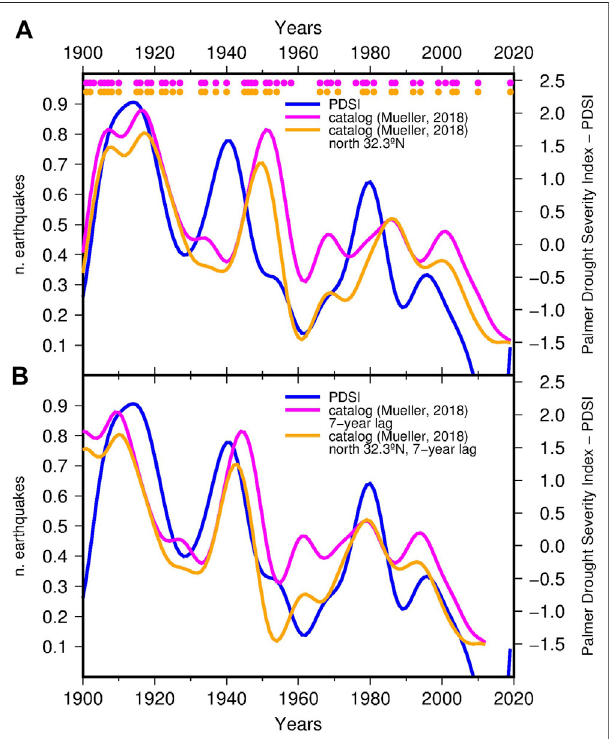
FIGURE 10 | PDSI averaged over the climate zone 6 – 7 (blue lines) compared with the time density of Mw ≥ 5.7 earthquakes in Southern California computed for the declustered seismic catalog by Mueller (2018), Mueller (2019) (lines in magenta) and for the same catalog with the southern limit moved to 32.3 ° N (lines in orange). (A) original data; (B) earthquake time densities anticipated by 7 years in order to maximize the correlation with PDSI (see also the results for the data sets 9 and 10 in Table 1 ). The dots indicate the time of occurrence of the earthquakes.